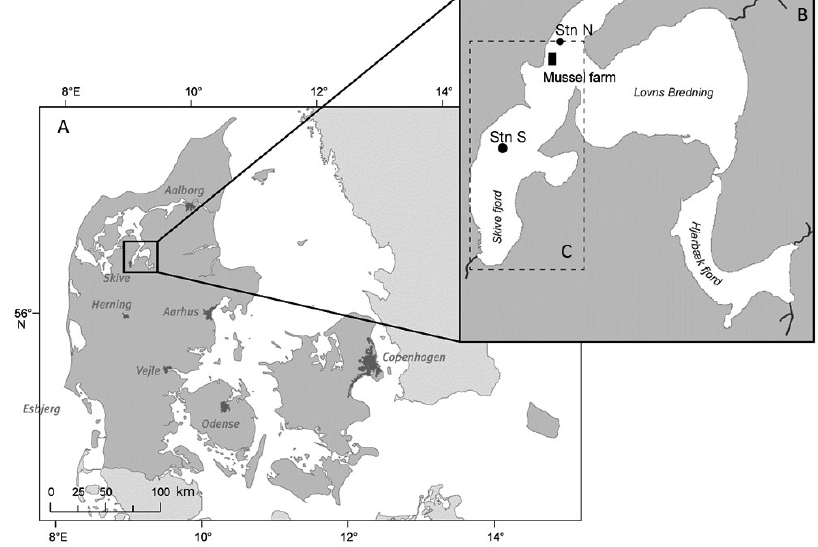
Fig. 1. (A) Location of the Skive Fjord complex, Denmark, with (B) a close-up of the model domain covering Skive Fjord, Lovns Bredning and Hjarbæk Fjord. The mitigation mussel culture unit optimized for nutrient removal is located in the northern part of Skive Fjord ( j ). The monitoring station providing data for bound- ary conditions, Stn N ( d ), is located north of the farm, whereas the monitoring sta- tion used for model validation, Stn S ( d ), is located south of the mussel farm. In the present study, basin scale is defined as (C) Skive Fjord, whereas local scale is related to a single mussel